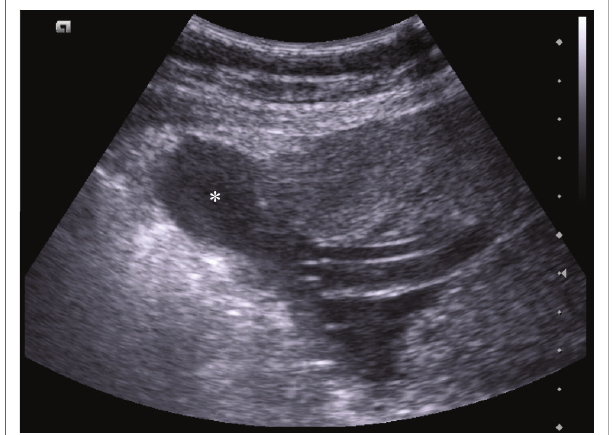
FIGURE 1: Transverse abdominal ultrasound demonstrating a well-circumscribed, anechoic structure (asterisk), adjacent to placental tissue, occupying the uterine fundus on the right. Communication with the uterine cavity is evident, in keeping with the amniocele demonstrated on magnetic resonance